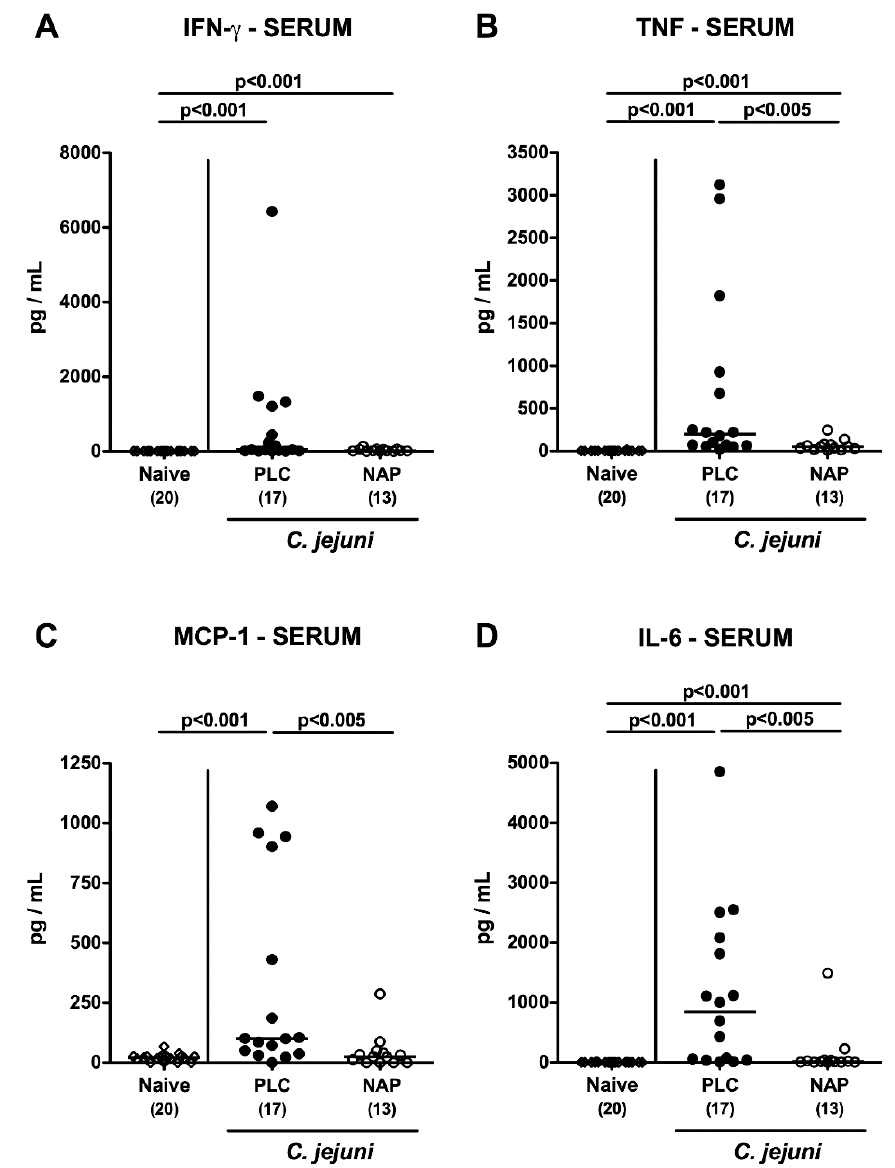
Figure 7. Systemic pro-inflammatory mediator secretion following NAP treatment of C. jejuni infected secondary abiotic IL10 − / − mice. On day (d) 0 and d1 secondary abiotic IL10 − / − mice were perorally infected with C. jejuni strain 81-176 by gavage and treated intraperitoneally with either synthetic NAP (open circles) or placebo (PLC; closed circles) from d2 until d5. On d6 post-infection, ( A ) IFN- γ , ( B ) TNF, ( C ) MCP-1, and ( D ) IL-6 concentrations were measured in serum samples. Naive mice served as negative controls (open diamonds). Medians (black bars) and levels of significance ( p -values) as determined by the Kruskal–Wallis test and Dunn’s post-correction, as well as numbers of analyzed mice (in parentheses) are indicated. Data were pooled from four independent